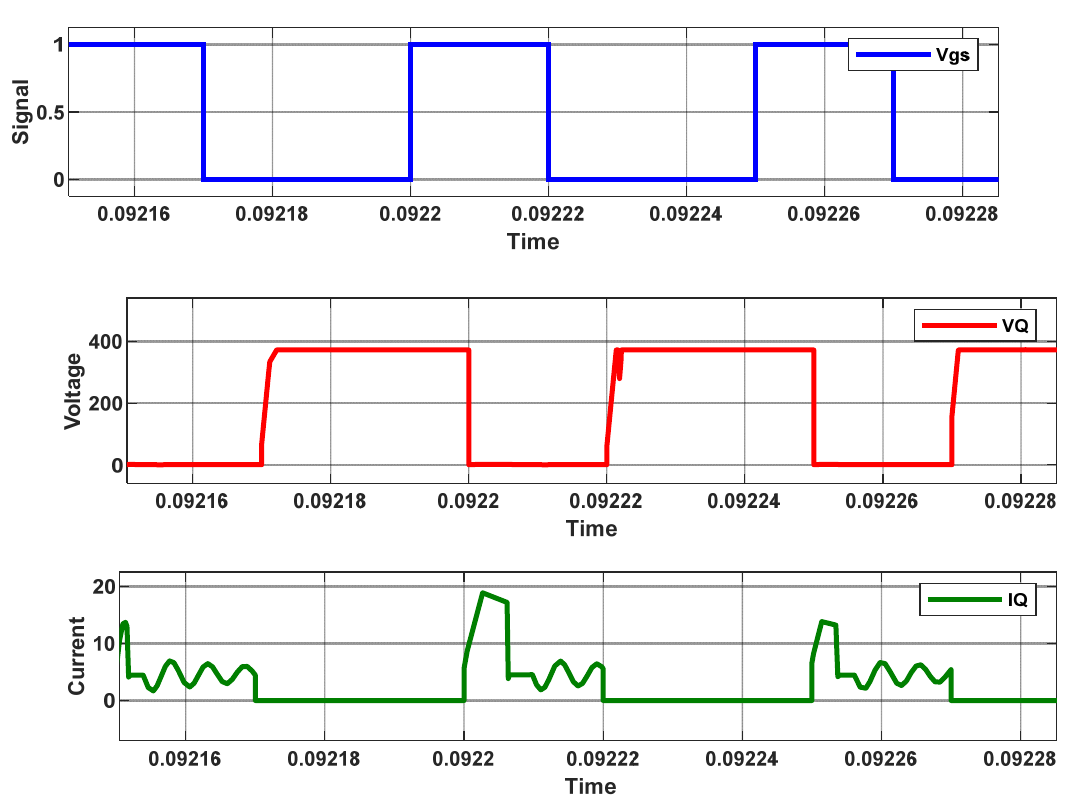
Figure 8. The switch voltage (red) and drain current (green) of the HFC converter.